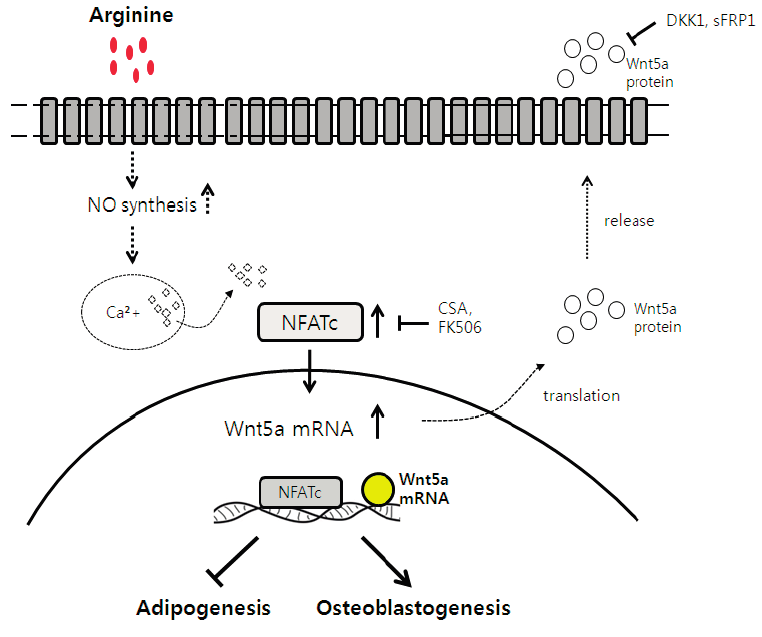
Figure 6. Proposed mechanism of pro-bone and anti-fat effect of arginine, mediated NO synthesis and induced NFATc accumulation, and subsequent increased Wnt5a mRNA expression in human mesenchymal stem cells. Indicates activation or induction; indicates inhibition or